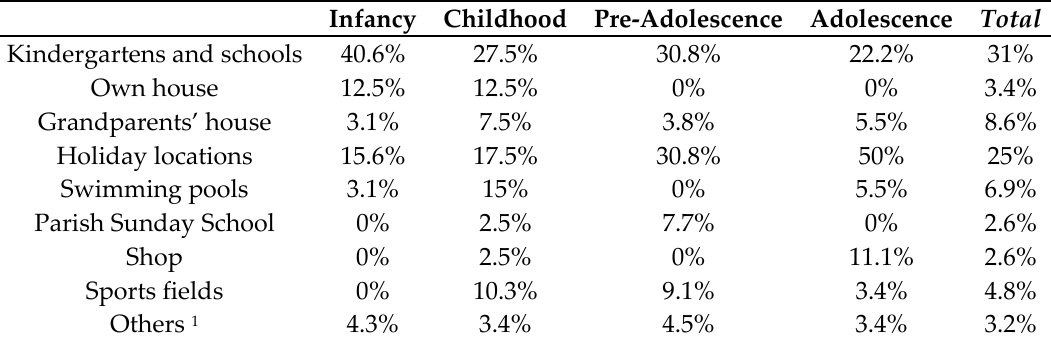
Table 5. “Places remembered and drawn”: percentages on the total number of the drawings assigned to this indicator